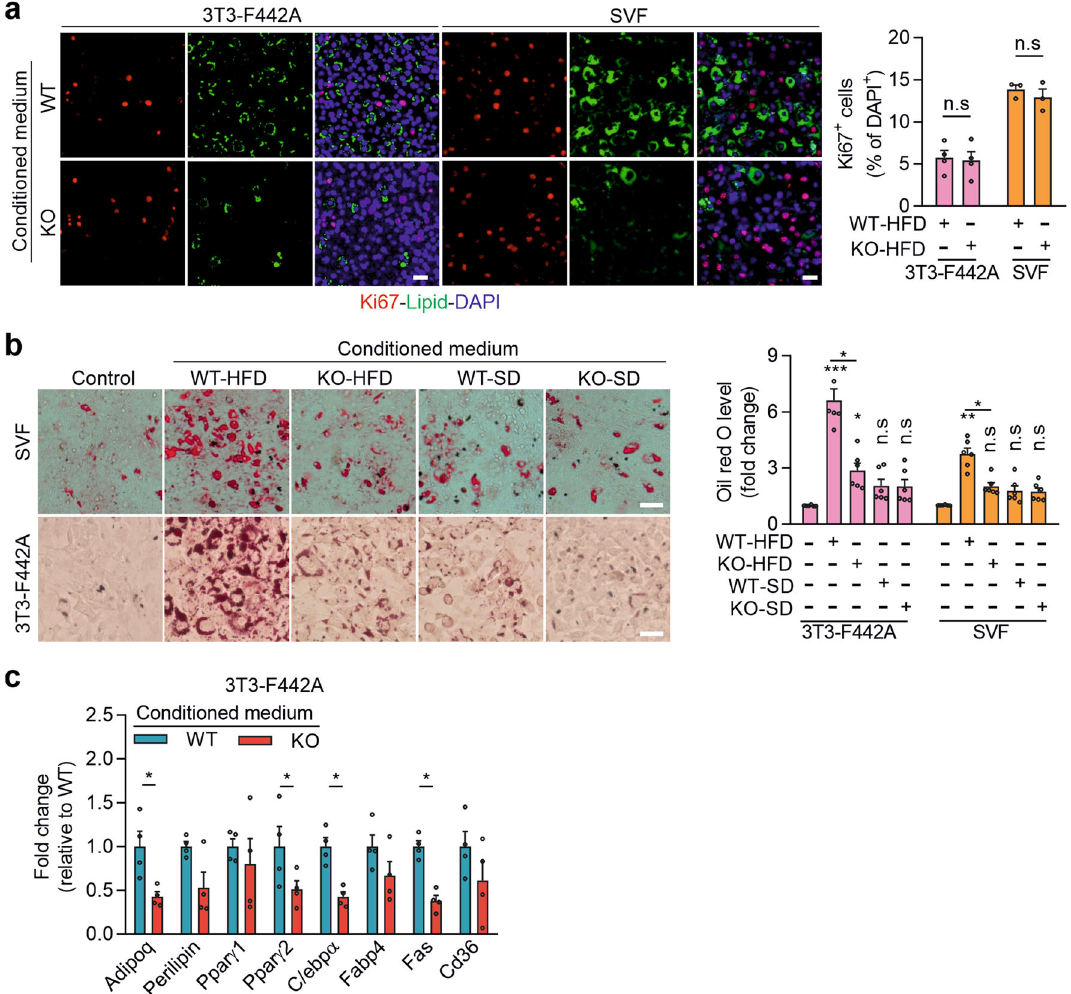
Fig. 5 Effect of conditioned medium from vWAT adipocytes on preadipocyte proliferation and differentiation. a – c Effects of conditioned medium from vWAT adipocytes prepared from wild-type (WT) and Ad-Piezo1-KO (KO) mice fed a HFD ( a – c ) or SD (b) for 16 weeks or of unconditioned medium (control in b ). In a , proliferation of 3T3-F442A cells or of cells of the SVF was visualized by staining for Ki67, and cells were counterstained with DAPI and BODIPY (lipid). Shown are representative images and the statistical evaluation ( n = 4 mice (WT and KO, 3T3-F442A), n = 3 mice (WT and KO, SVF); at least 10 fi elds were analyzed per mouse). Bar length: 50 μ m. In b , SVF cells or undifferentiated 3T3-F442A cells were exposed to the medium and stained with Oil-red-O. Shown are representative images and the statistical evaluation of Oil-red-O content ( n = 6 mice (for all groups)); bar length: 50 μ m. In c , expression of different adipocyte marker genes in 3T3-F442A cells ( n = 4 mice (for all groups)) was determined. Shown are mean values ± s.e.m.; * P ≤ 0.05; ** P ≤ 0.01; *** P ≤ 0.001; n.s., not signi fi cant (compared to control in b ) (two-tailed non-parametric Mann – Whitney U -test). Source data are provided as a Source data fi